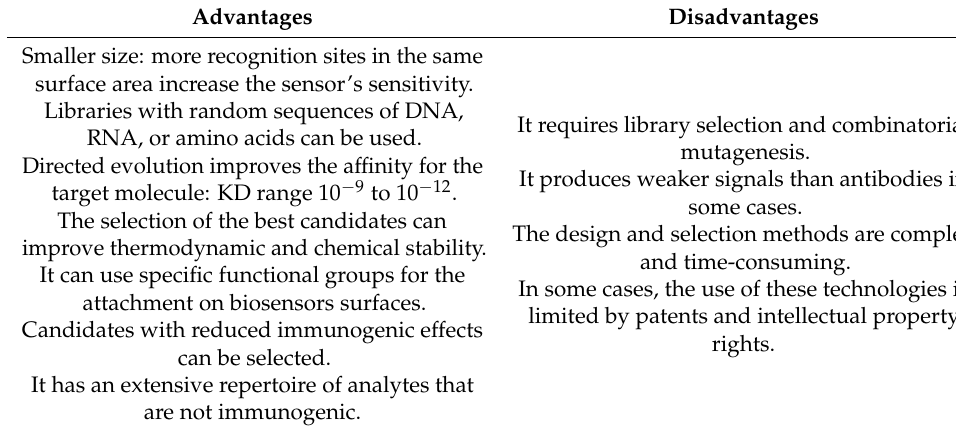
Table 5. Advantages and disadvantages of antibody mimetics